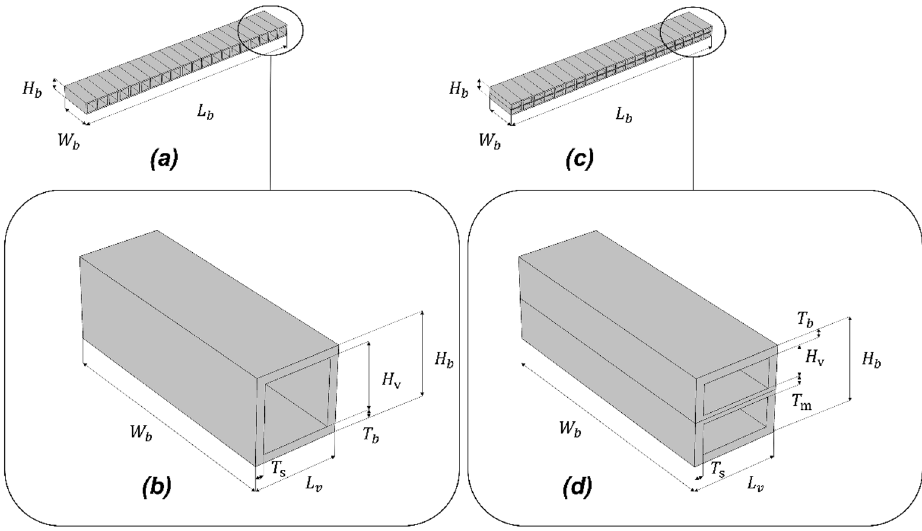
Figure 4. The beam domain example for 20 voxels model with single symmetric or asymmetric void setting ( a ) and double void setting ( c ). The details of voxel geometry settings are shown in ( b , d ), respectively. In these particular examples, the voxel height H b is 10 mm for both single and double void settings ( b , d ). The hollow structure’s height H v is 8 mm for single void model in ( b ) and H v is 4 mm for double void model in ( d ). (Images are created by the authors using Solidworks Educational Version 30.3.1.2 2022-23).